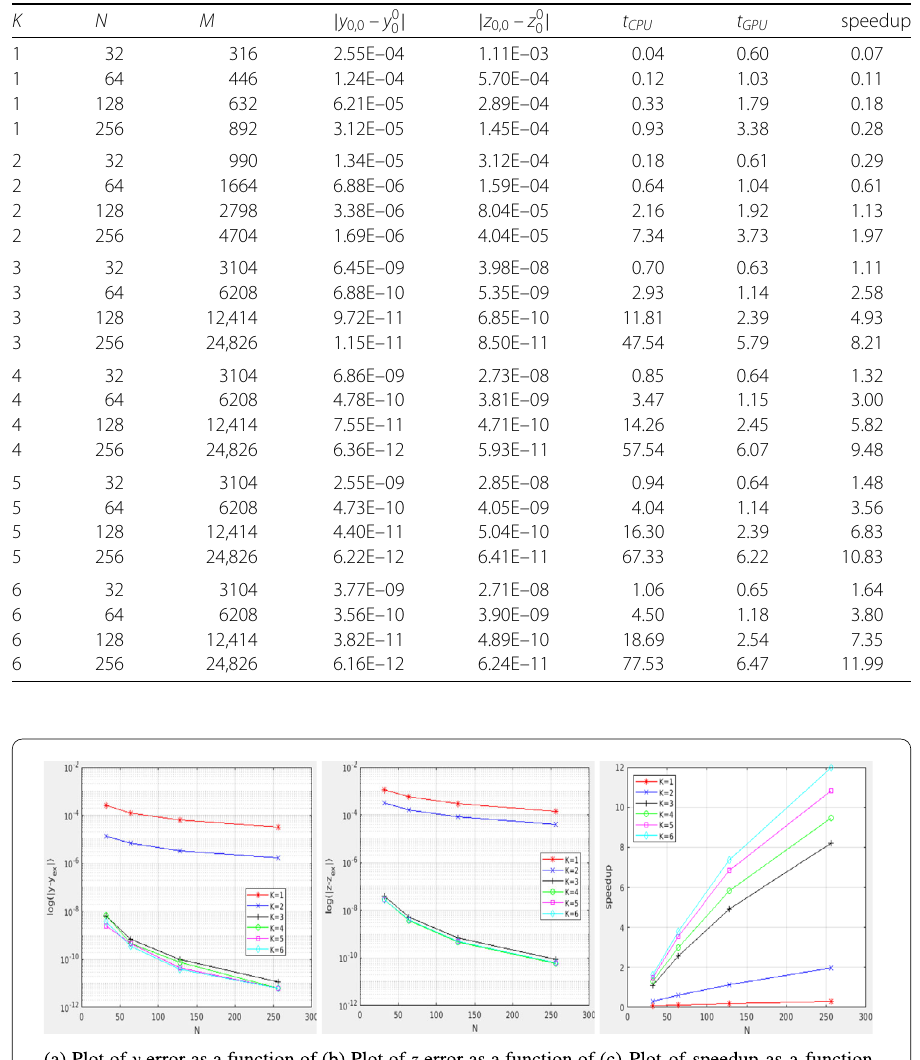
ated for the Black-Scholes BSDE for N = 256 and a high K , namely K = K y = K z = 6. The optimization iteration process is the same as in Example 2. The final speedup is 31 × .